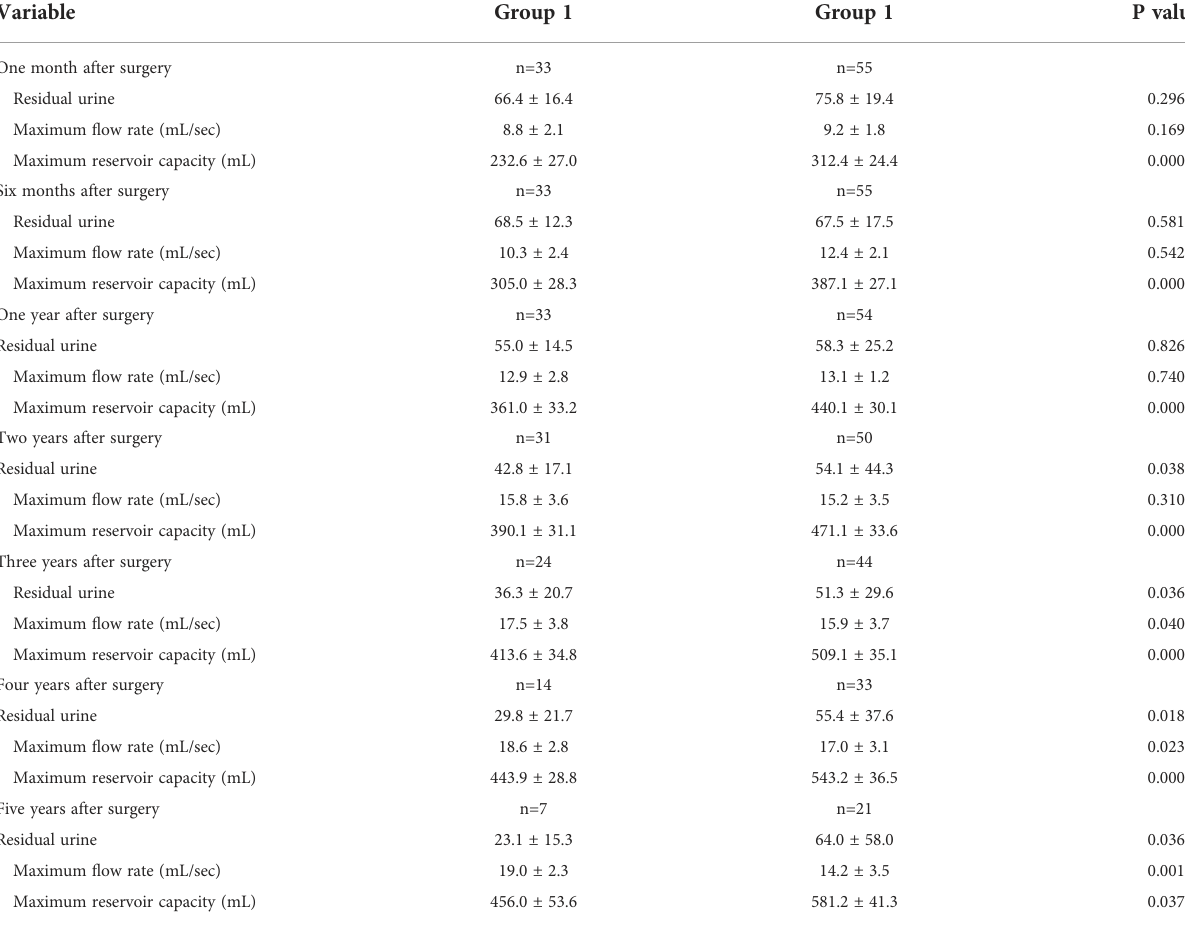
TABLE 5 Patient ’ s urodynamic